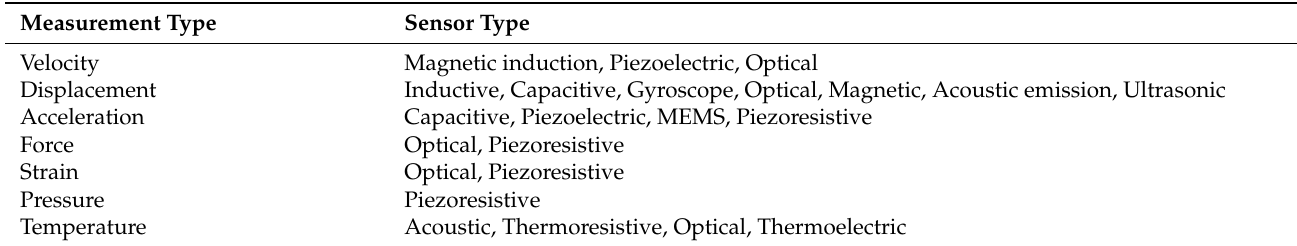
Table 7. Types of measurements and